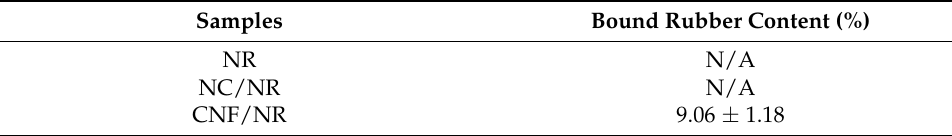
Table 4. Bound rubber content of NR, NC/NR, and